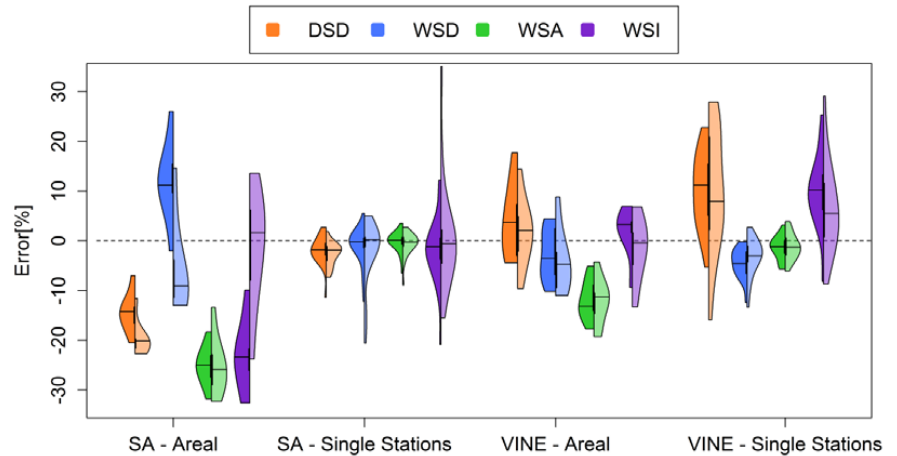
Figure 9. Errors of mean values of event characteristics based on areal and single sites resulting from two models used for multisite synthesis for summer (left plots of violins) and winter (right plots of violins) events for all stations.